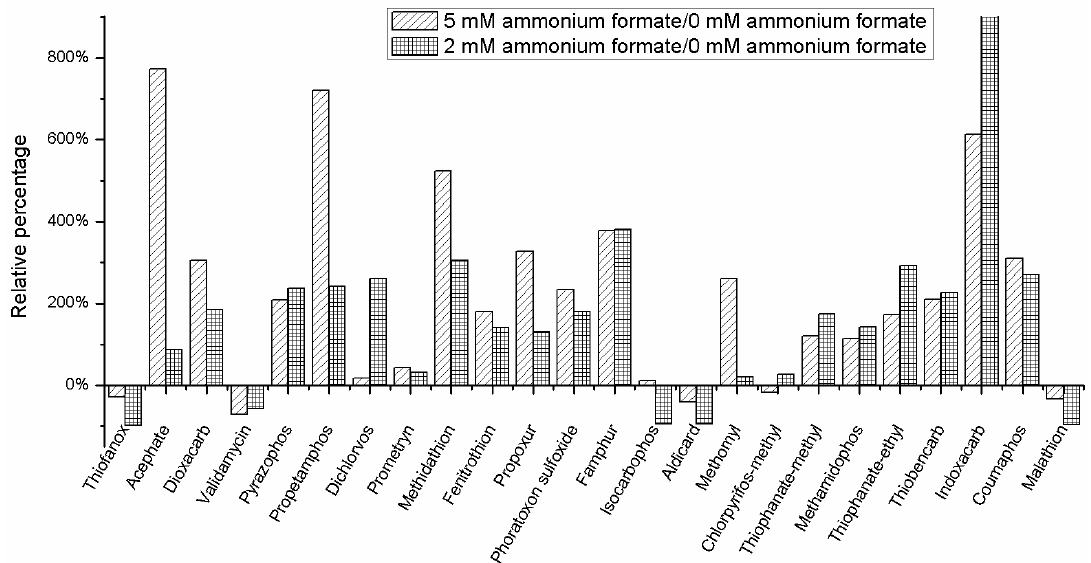
Figure2. Relativesignalenhancementordepressionfortypicalcompoundswithdi ff erentconcentrations Figure 2. Relative signal enhancement or depression for typical compounds with different of ammonia formate or without this bu ff er in the mobile phase in the same concentrations of ammonia formate or without this buffer in the mobile phase in the same gradient.